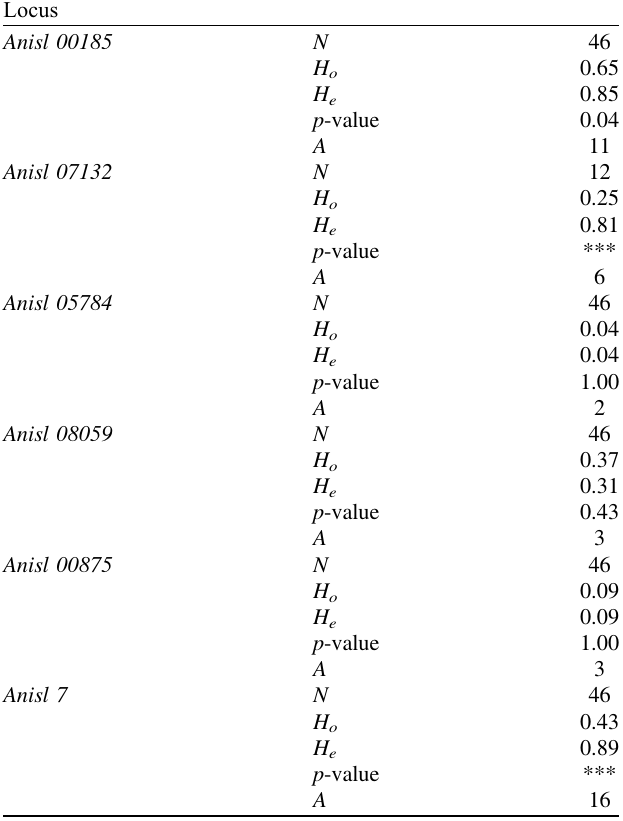
Table 1. Genetic diversity at six microsatellite loci in adult specimens of A. berlandi, analysed in the present study.